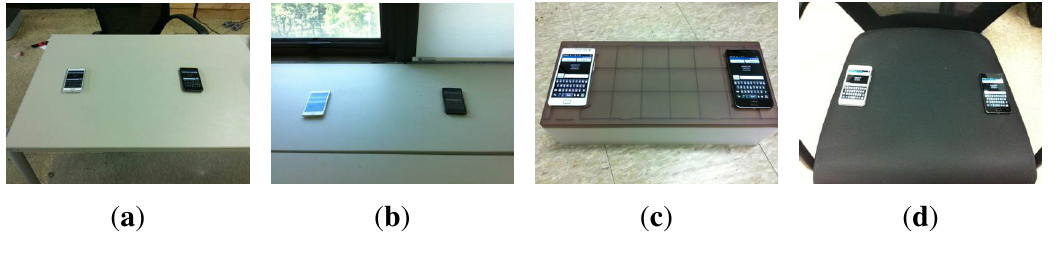
Figure 9. Different communication medium objects used in experiments. ( a ) wooden